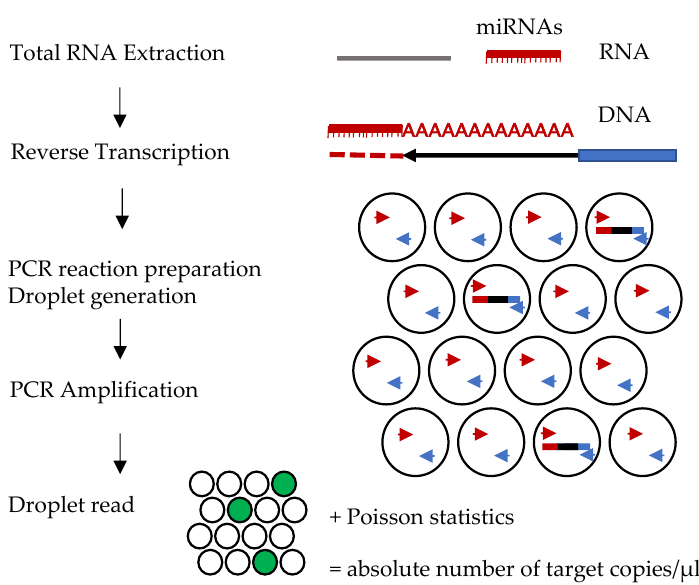
Figure 4. Diagram of droplet digital PCR workflow. Partitioning is the principle underlying quantifi- cation. Green colored circles indicate droplets in which target amplification